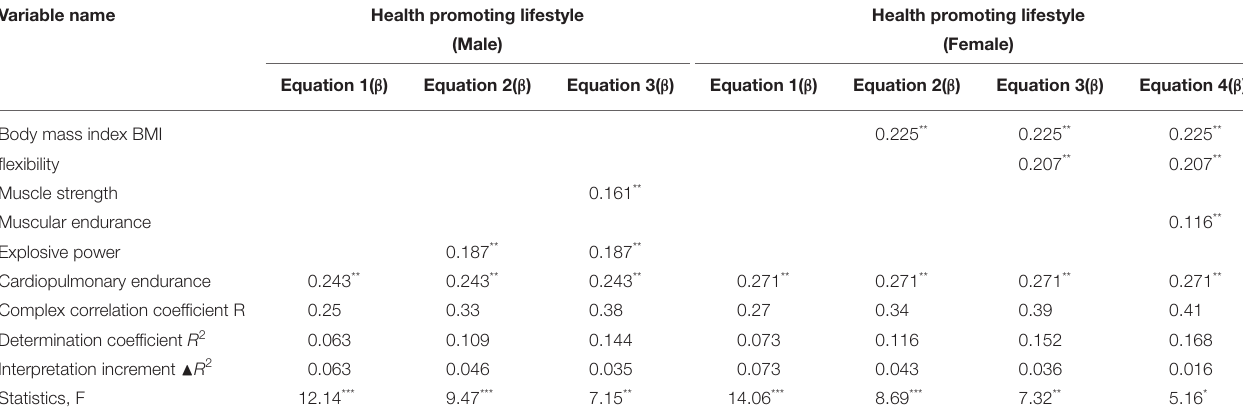
TABLE 3 | Statistical table of multiple stepwise regression analyses of health and physical fitness of men and women on their overall health promoting lifestyle.